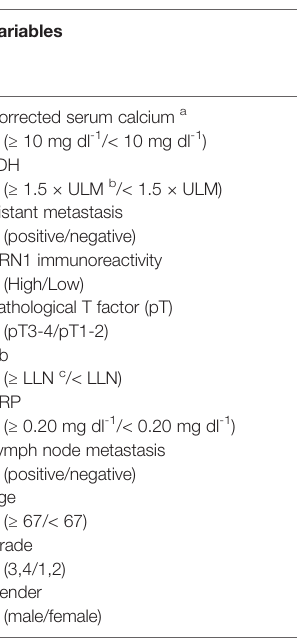
TABLE 2 | Univariate and multivariate analyses of overall survival in 100 clear cell RCC